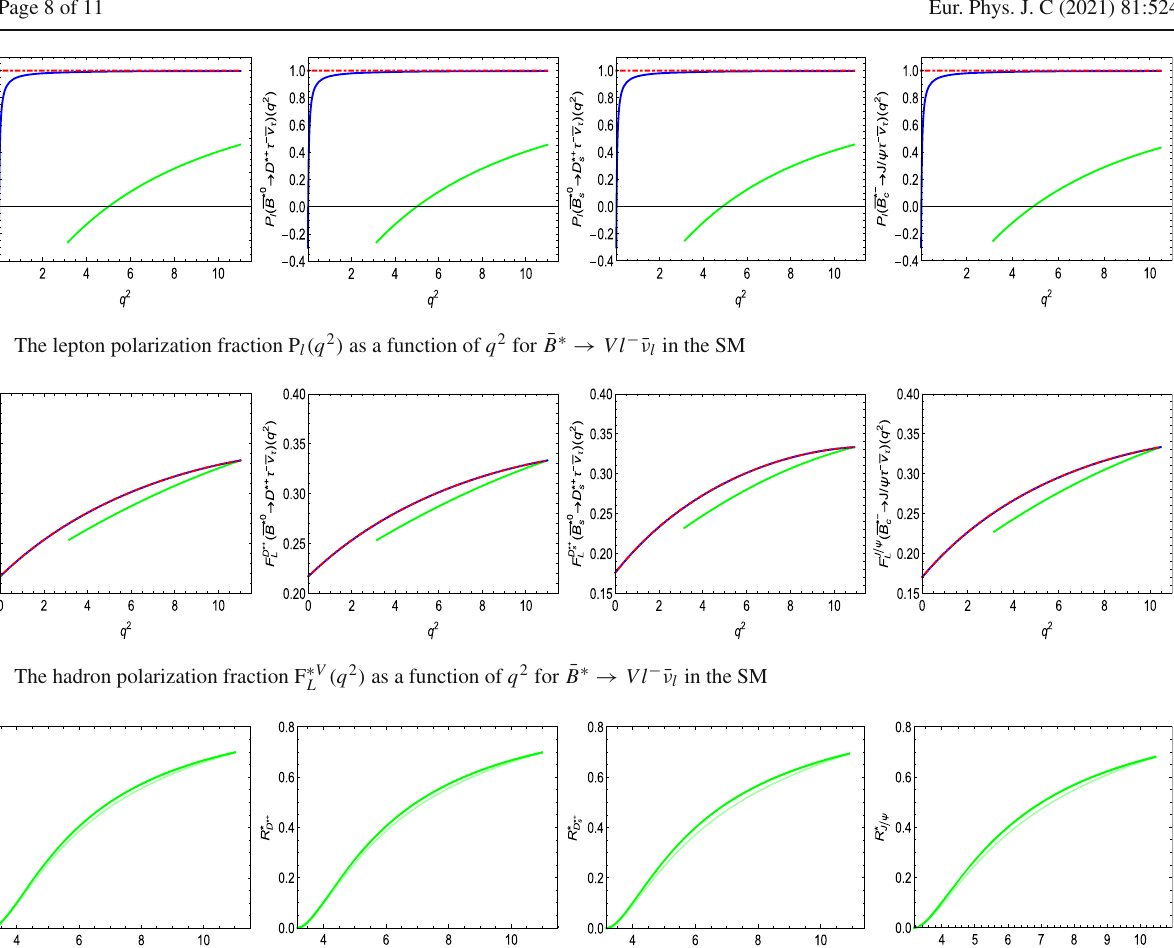
( q 2 ) as a function of q 2 for ¯ B ∗ → Vl − ¯ ν V ( q 2 V